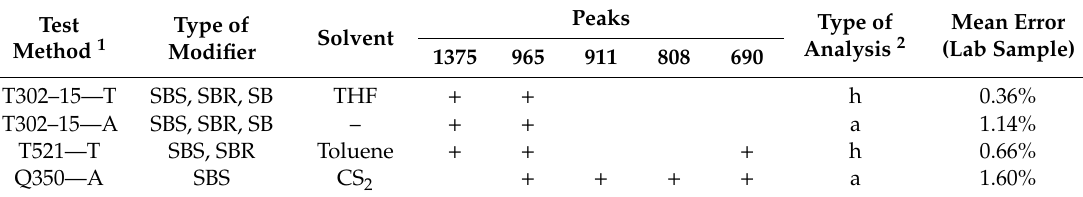
Table 5. Comparative analysis of the test